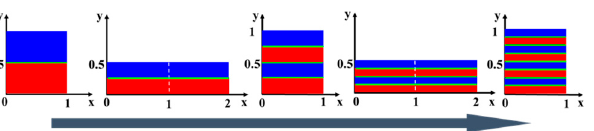
Figure 2. Schematic diagram of Baker transformation with fluid cross-sections in red and blue.